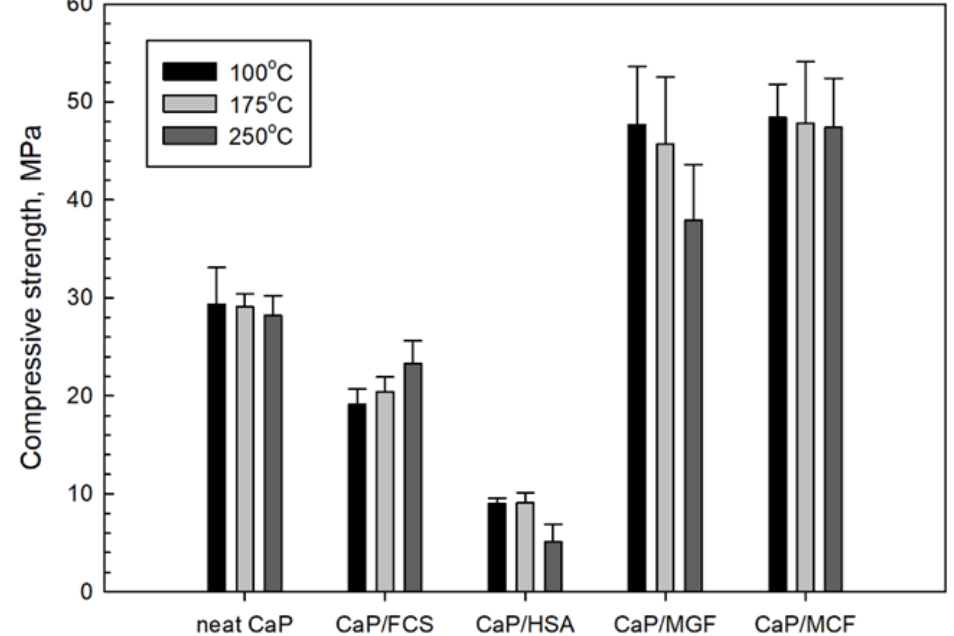
Figure 23. Compressive strengths of 100-, 175-, and 250 ◦ C-autoclaved neat CaP and CaP cements made with different aggregates and reinforcements.